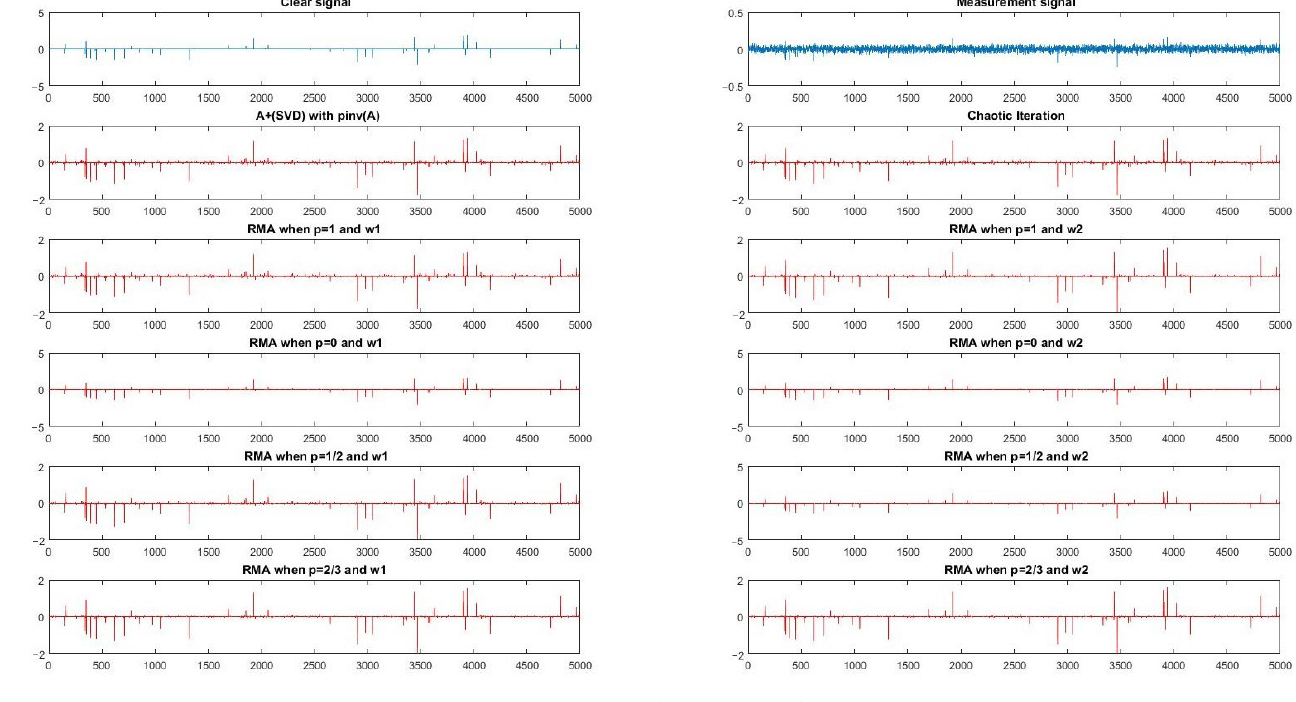
Figure 2. (m, n) = (1000, 5000). Table 1. The comparison of ( m , n , rank ( A ) , n NZ ) = (250, 500, 200,